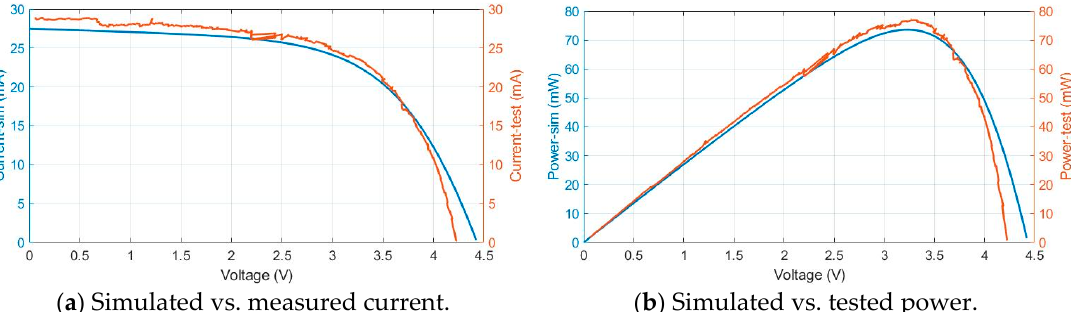
( b ) Simulated vs. tested power. With 0.25 sun and 46 °C, short circuit current is 27 mA, Figure 6a; MPPT (maximum power point